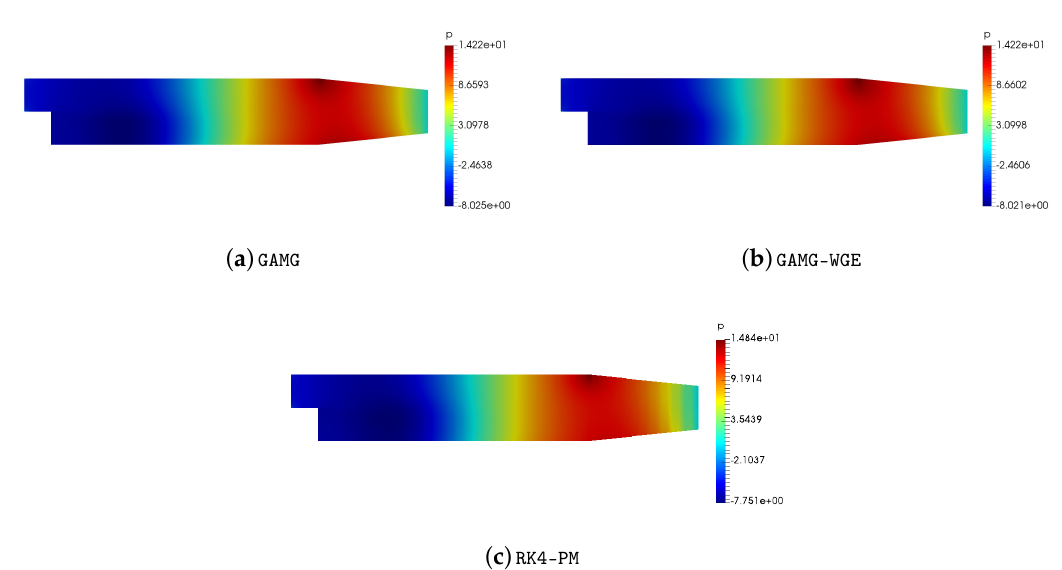
Figure 7. The distribution of the p Rel field at 0.3s using different methods in pitzDaily.